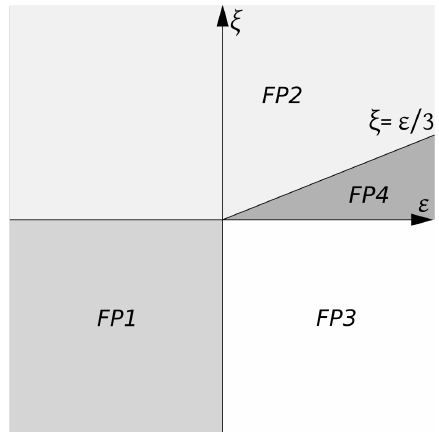
Figure 1. Regions of stability of the fixed points in the model (22). Different areas correspond to the values of the parameters for which points FP1–FP4 are IR attractive. The region FP1 corresponds to the mean field theory while the regions FP2, FP3, and FP4 correspond to the regimes where only the turbulent advection is relevant, only the nonlinearity of the Hwa–Kardar (HK) equation is relevant, and both the advection and the nonlinearity are relevant,